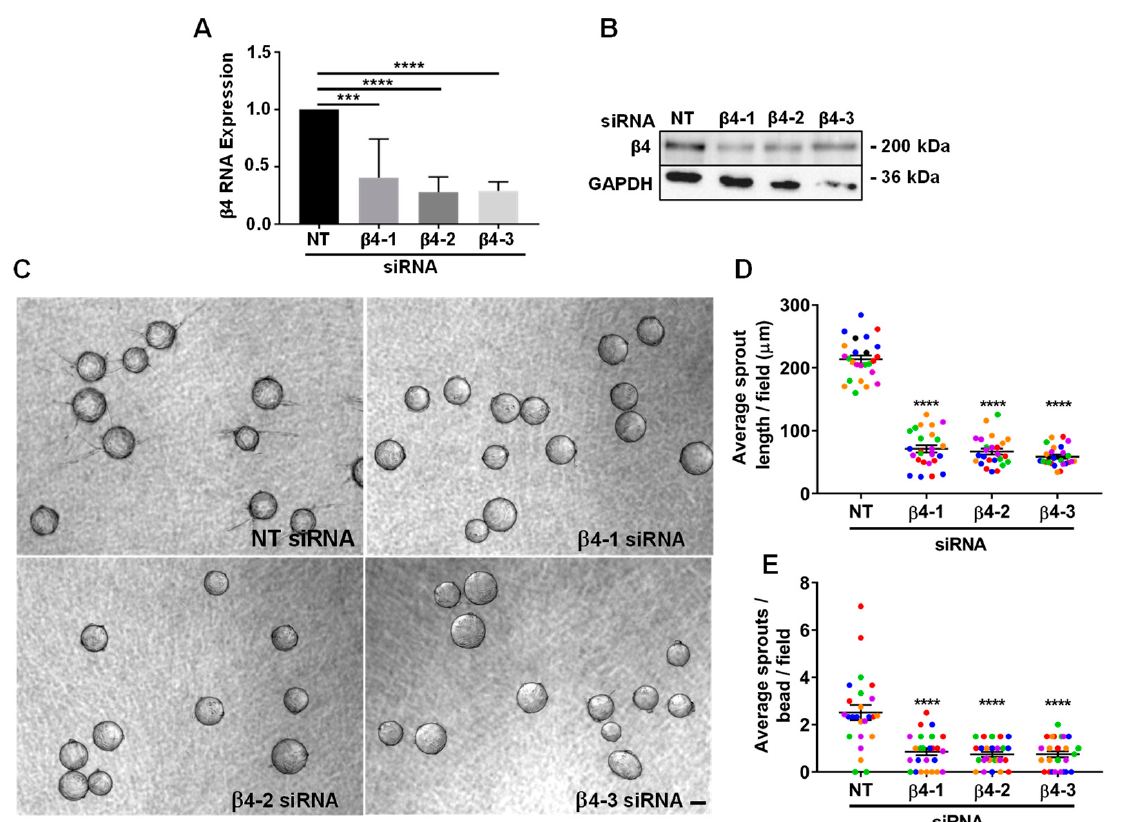
Figure 2. Integrin α 6 β 4 regulates endothelial morphogenesis: ( A ) The efficiency of β 4 depletion using 3 siRNA targeting sequences was determined by qPCR. Data were normalized to β -actin and then to non-targeting (NT) control. Plotted is the mean RNA expression ± s.d. n = 5 independent experiments; ( B ) representative western blot showing the efficiency of β 4 depletion at the protein level. Endothelial cells from the same batches of endothelial cells depleted of the β 4 subunit used in experiments presented in Figure 2 were employed in bead-sprout assays; ( C ) shown are representative images of 6-day bead sprouts transfected with non-targeting and β 4-targeting siRNA sequences 1–3. Scale bar = 100 µ m; ( D , E ) depletion of α 6 β 4 expression inhibits sprouting. Quantitation of sprout length (top) and number of sprouts (bottom) from 6–8 beads in each of five randomly selected fields in five independent experiments; ( D ) plotted is the average sprout length per field ± s.e.m. n = 25 fields; ( E ) quantitation of the average sprouts per bead per field ± s.e.m. Each independent experiment is represented by a distinct color. Data were analyzed using two-tailed Student’s t -test. Each independent experiment is represented by a distinct color. *** p ≤ 0.001, **** p ≤ 0.0001.